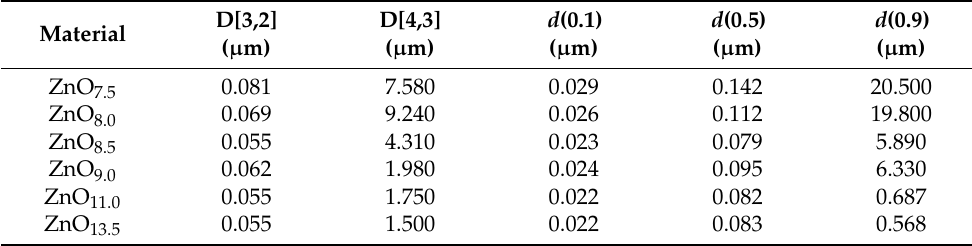
Figure 10. Particle size distribution of ZnO samples synthesized hydrothermally at pH 7.5, 8.0, 8.5, 9.0, 11.0, and 13.5. Table 5. Particle size distribution data of ZnO x synthesized at various pH (7.5–13.5) of reaction, where x subscripts indicate the exact pH reaction conditions.